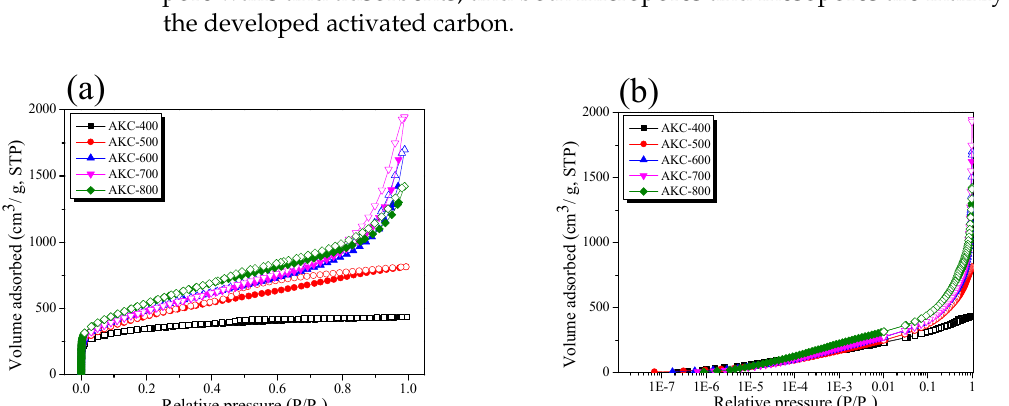
Figure 4. N 2 /77 K isotherm adsorption-desorption curves of kenaf-derived activated carbons as a function of various phosphoric acid activation temperature; ( a ) normal and ( b ) logarithmic.